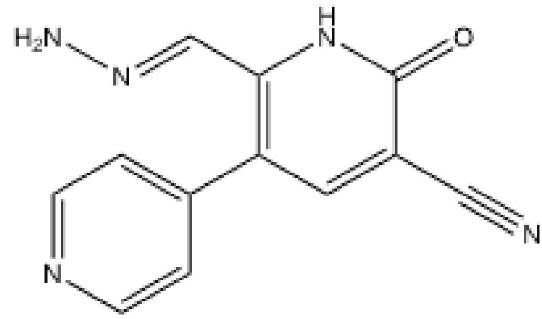
Figure 3. Structure of OK-1035.